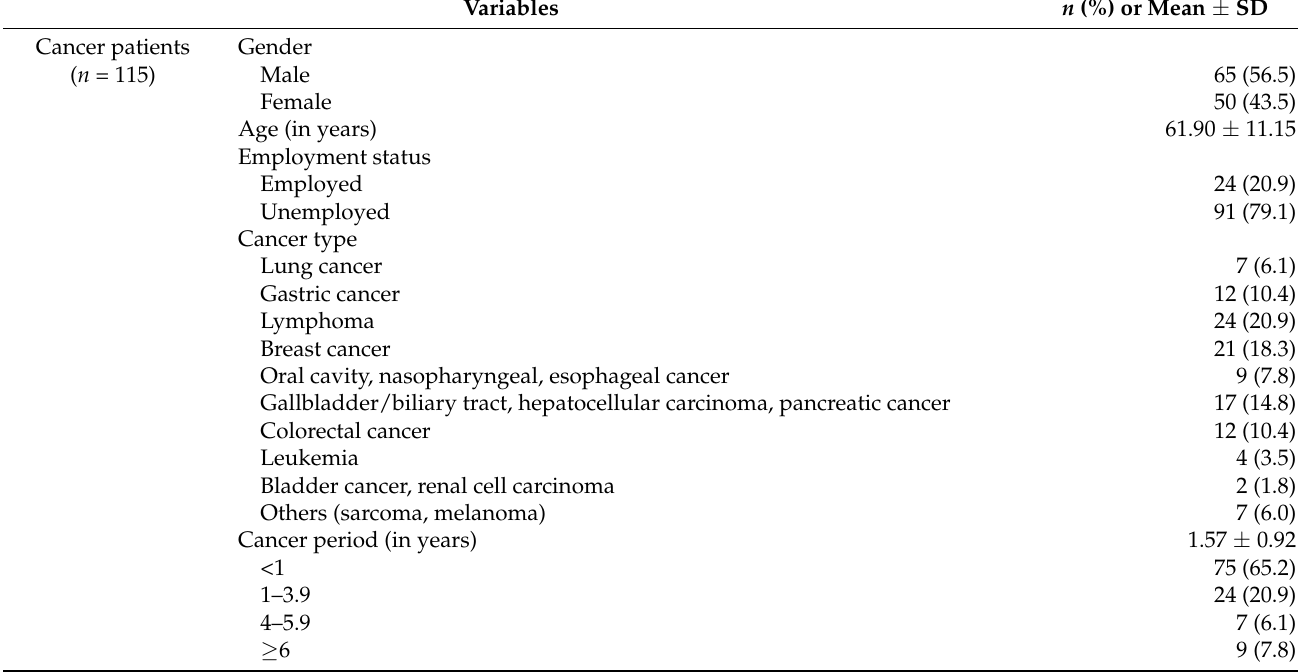
Table 1. Characteristics of the participants ( N = 115